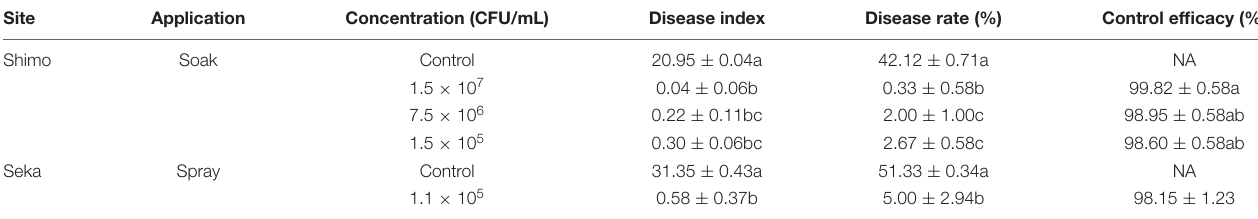
TABLE 4 | Effect of Bacillus amyloliquefaciens Y2 on tobacco rot in curing barns (Shimo, Yunnan and Seka, Yunnan) experiments.